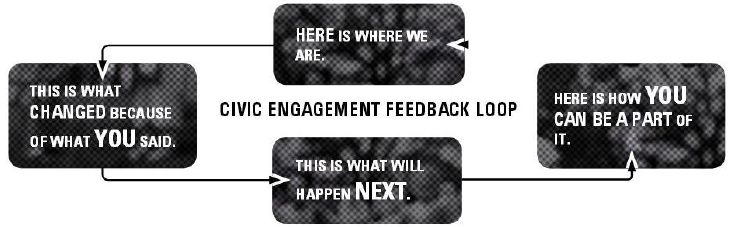
Figure 2. The civic engagement feedback loop. (Image credit: Detroit Future City: 2012 Detroit Strategic Framework Plan).